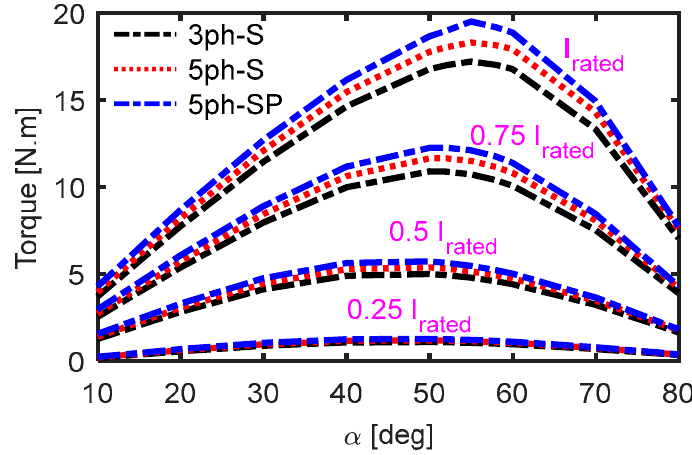
Figure 4. Torque at different current and at optimal angles.